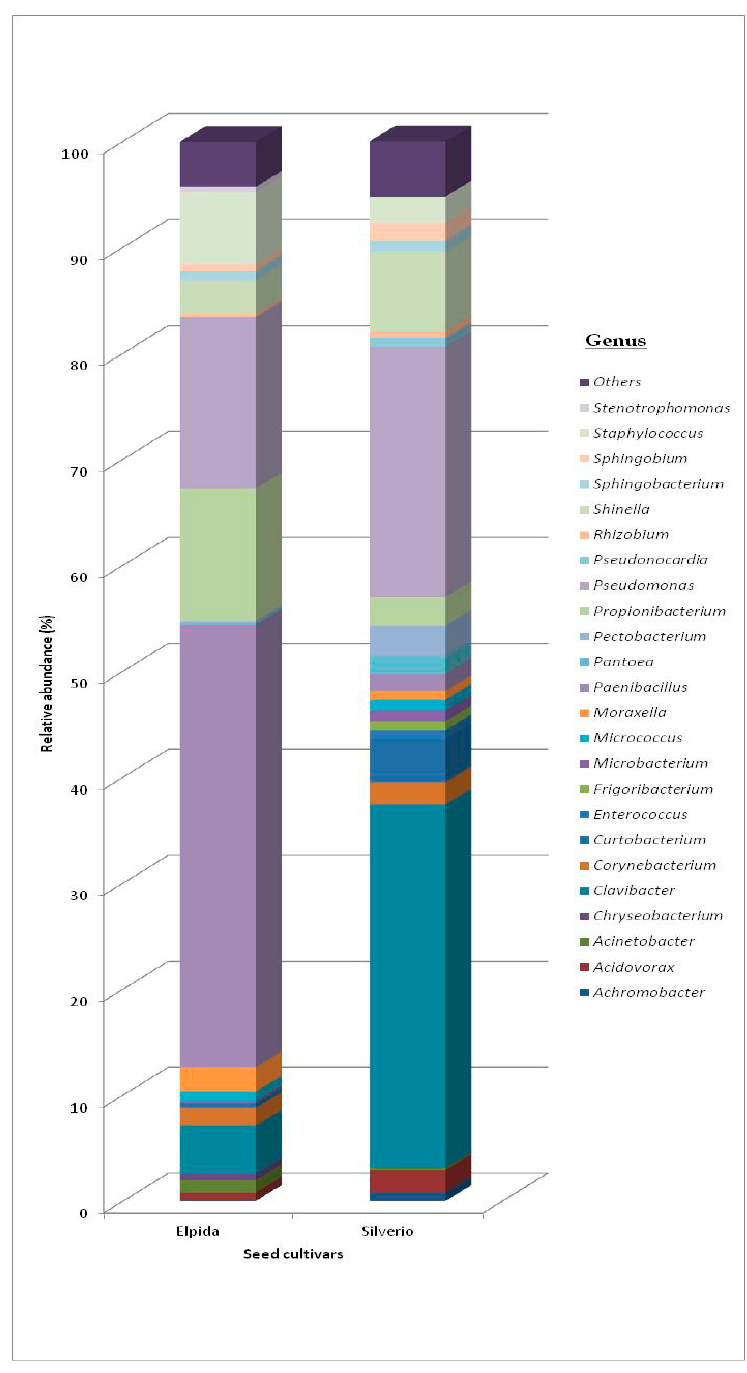
Figure A1. Taxonomic profiles of the bacterial community in each system at genus level with the relative abundance (>0.5%). The genus with relative abundance <0.5%, were grouped in “Others”.